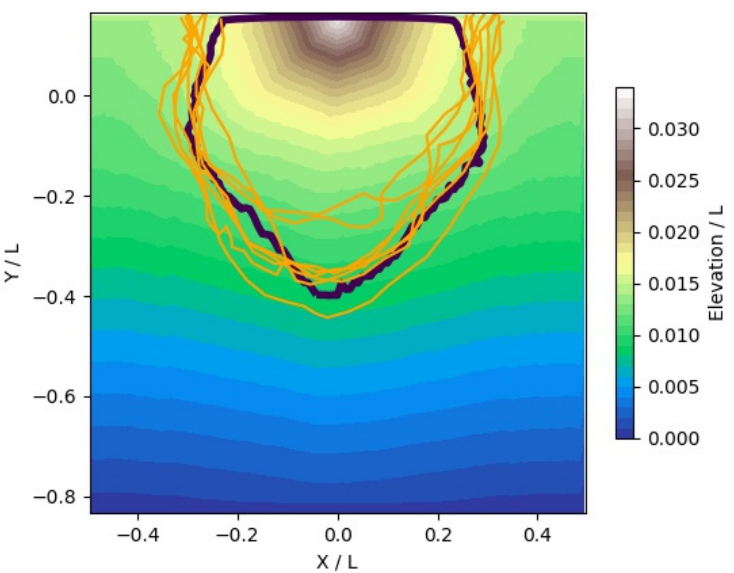
Figure 4. Alluvial fan geometry obtained after one hour of fan building without tectonics. The color scale gives the calcu- lated elevation of the best-fitting numerical model with 𝜅 (cid:3045)(cid:3036)(cid:3049)(cid:3032)(cid:3045) = 10 (cid:2879)(cid:2873) , 𝑣 (cid:3046) = 1 𝑚. 𝑦𝑟 (cid:2879)(cid:2869) , 𝜅 (cid:3035)(cid:3036)(cid:3039)(cid:3039) = 8. 10 (cid:2879)(cid:2872) 𝑚. 𝑦𝑟 (cid:2879)(cid:2869) , and 𝑛 = 2.5 . Orange lines give the location of the alluvial fans’ boundaries obtained in the analog experiments (see Figure 3). The thick black line is the fan boundary obtained from the numerical approach. Distance and elevation are normalized by the model size 𝐿 , which is equal to 60 cm and 6 km in analog and numerical models, respectively. In the analog experiments, the fan apex height ℎ (cid:3028) is 1.85 cm, which corresponds to an elevation/L ratio of